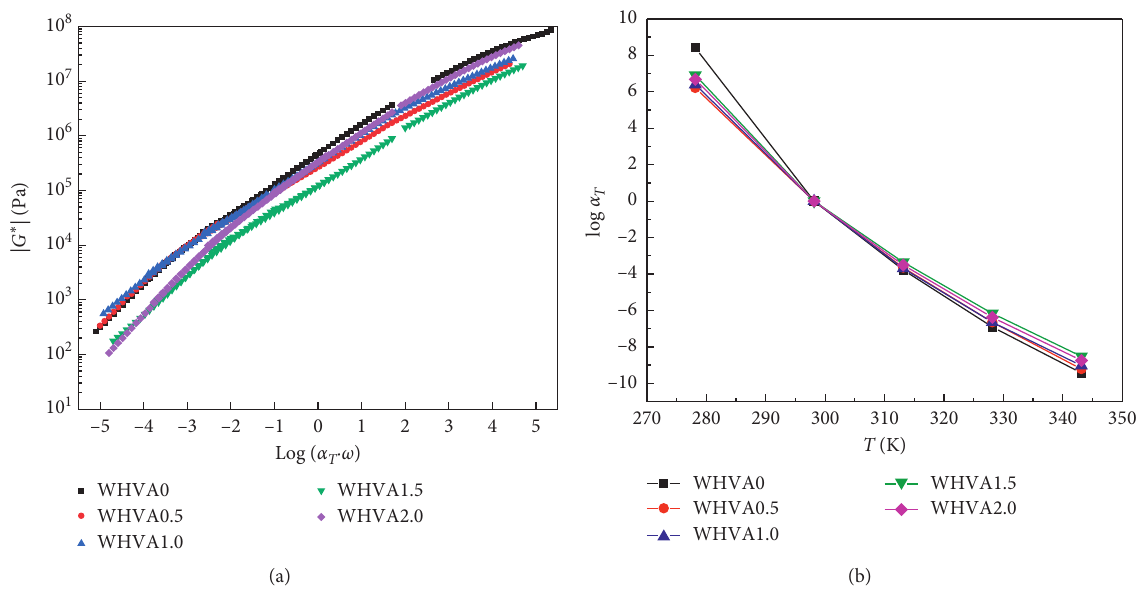
Figure 3: (a) Master curves and (b) shift factors at different temperatures for warm-mix HVA.